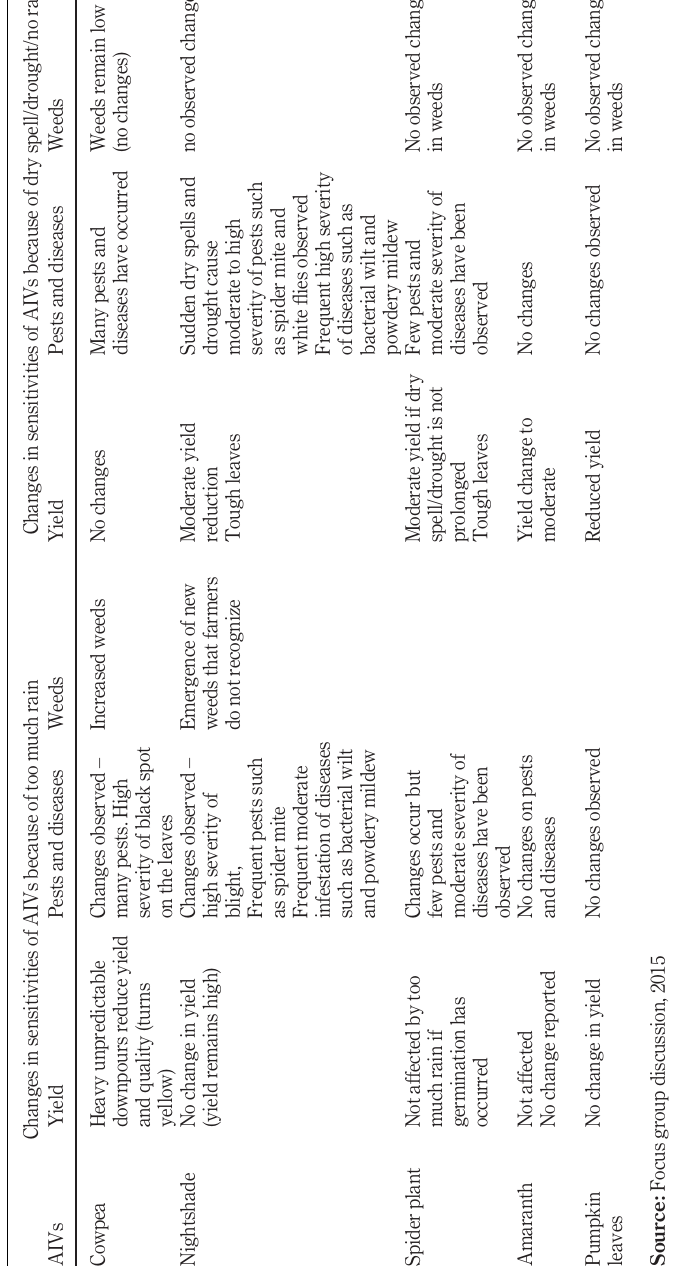
Table XI. Comparison of the changes in sensitivities of common AIVs to changes in rainfall